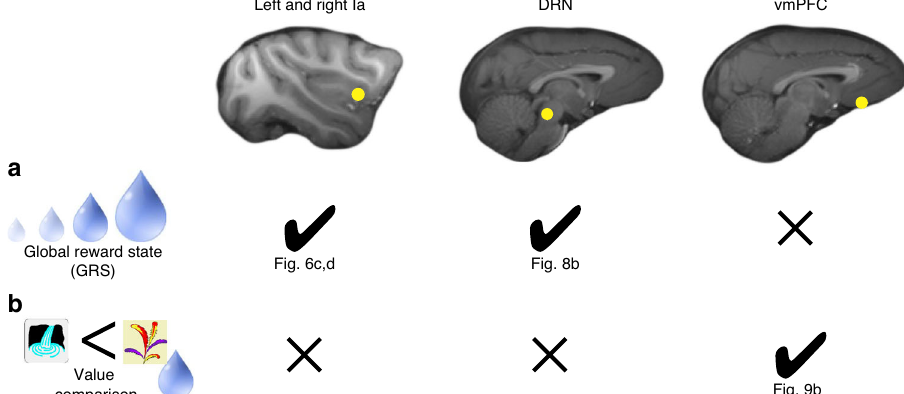
Fig. 10 Computations of learning and choice in Ia, DRN, and vmPFC. Check marks indicate observed effects with references to the respective fi gure panel. X indicates absent effects as detailed in Supplementary Fig. 7. a Bilaterally in Ia as well as in DRN, we found a representation of the GRS, i.e. a choice- unlinked general representation of recent reward. We did not observe such a non-contingent general reward signal in vmPFC. b In vmPFC, however, we found a value difference signal capturing the difference in contingent reward expectation of the chosen compared to the unchosen option (DV value ). These signals were clearly absent in Ia and DRN. The activity patterns in Ia and DRN suggest they are more related to learning than to decision making. (leftmost symbols used in the fi gure are adapted from Chau et al. 19